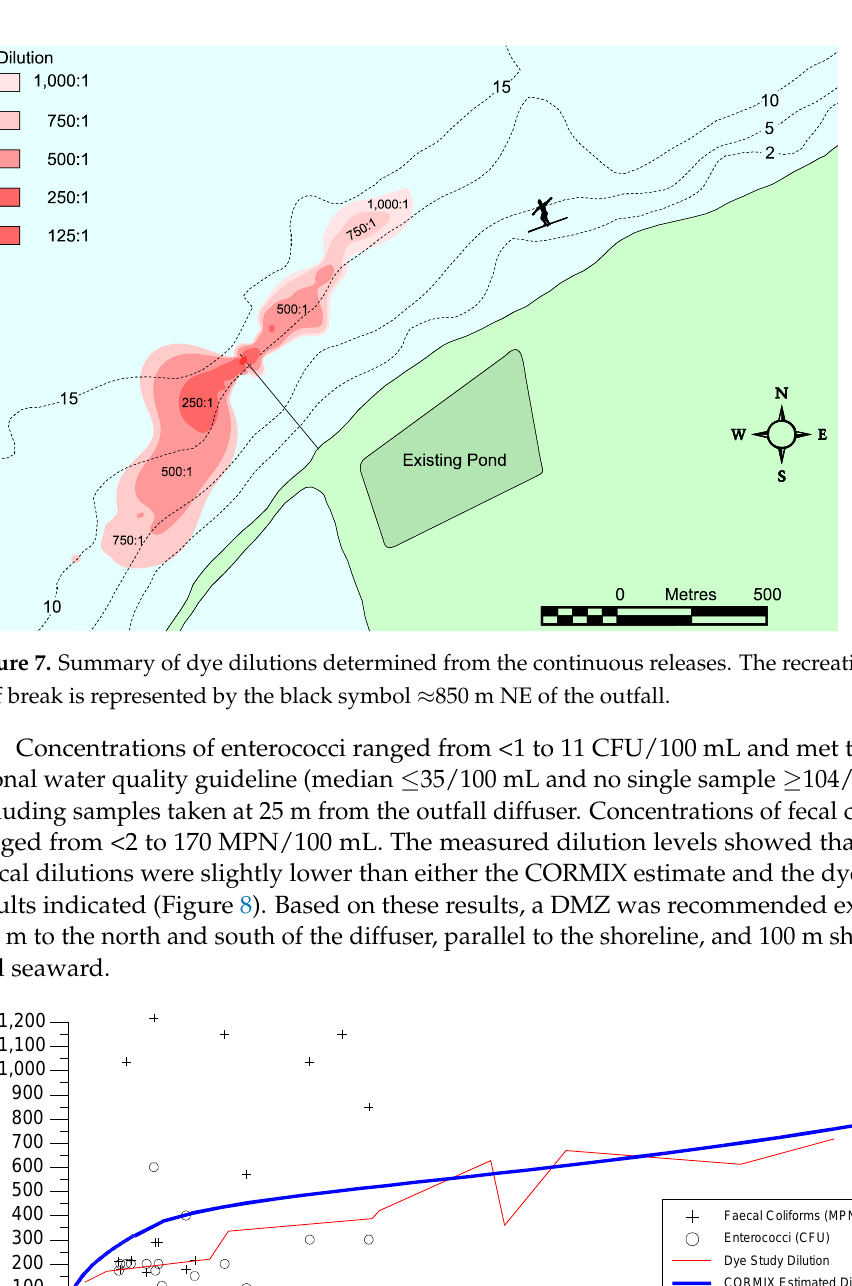
Figure 8. Wastewater dilutions estimated from dye studies and CORMIX modelling and concentra- tions of fecal coliforms and enterococci as a function of distance from the wastewater outfall.